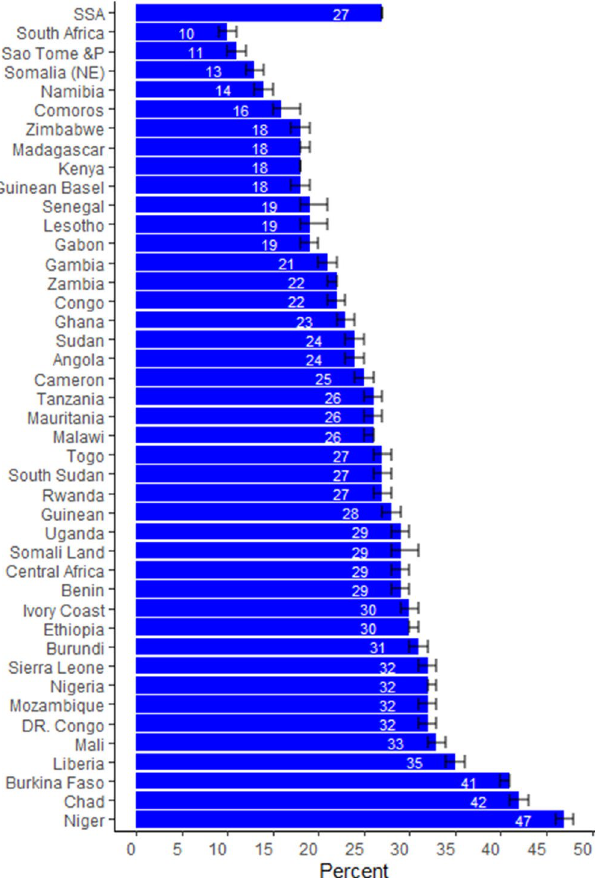
Figure 1. The proportion of women who suffer at least one child death with the confidence